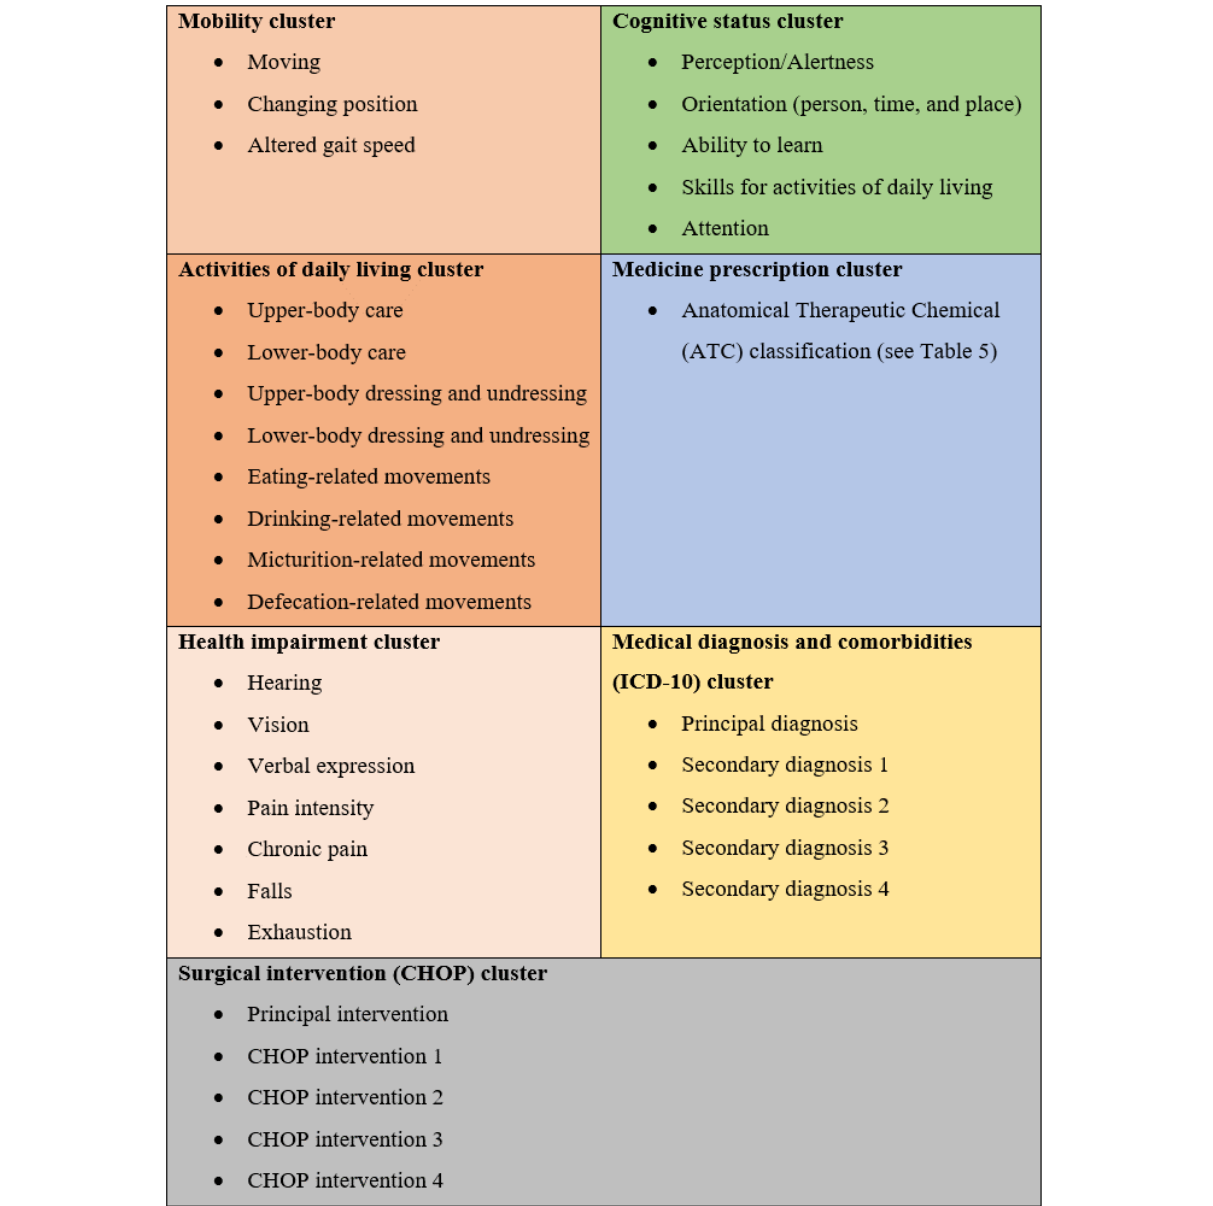
Figure 1. Structure and content of the data set